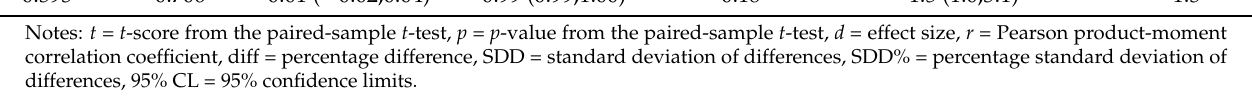
Table 3. Comparison between the actual 1RM snatch and the snatch th computed from the snatch pull FvR 2 . t (7) p d (95% CL) r (95% CL)